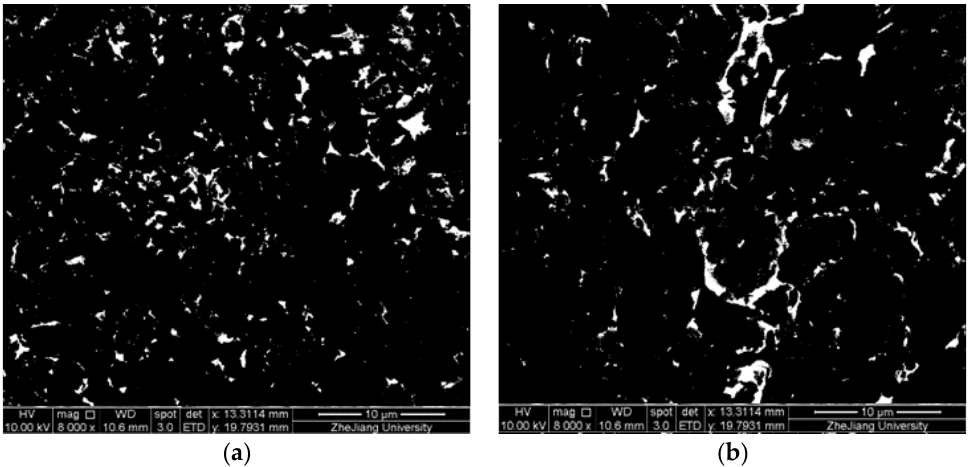
Figure 3. Pore morphology of soft clay: ( a ) unfrozen soil; ( b ) frozen-thawed soil. Table 1. Experimental